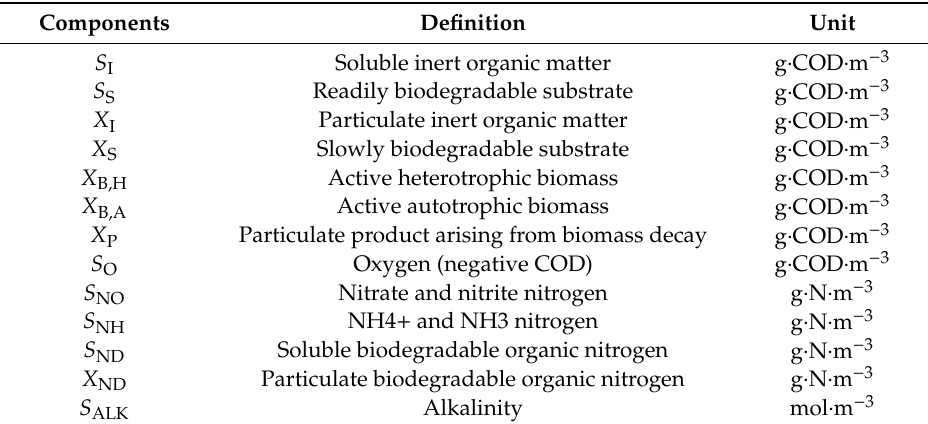
Table A5. The 13 components of ASM1.